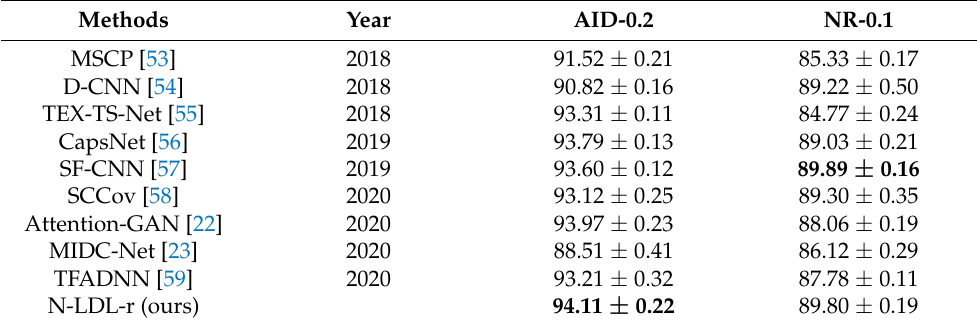
Table 4. OA (%) comparisons with state-of-the-art methods.